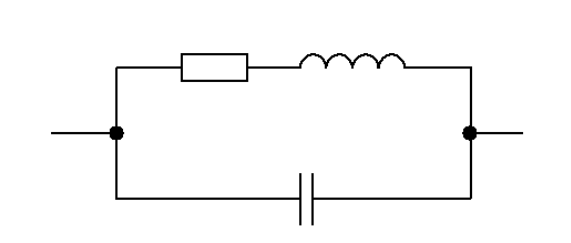
Fig. 2. Schematic model of IEG with equivalent L eq , R eq , C